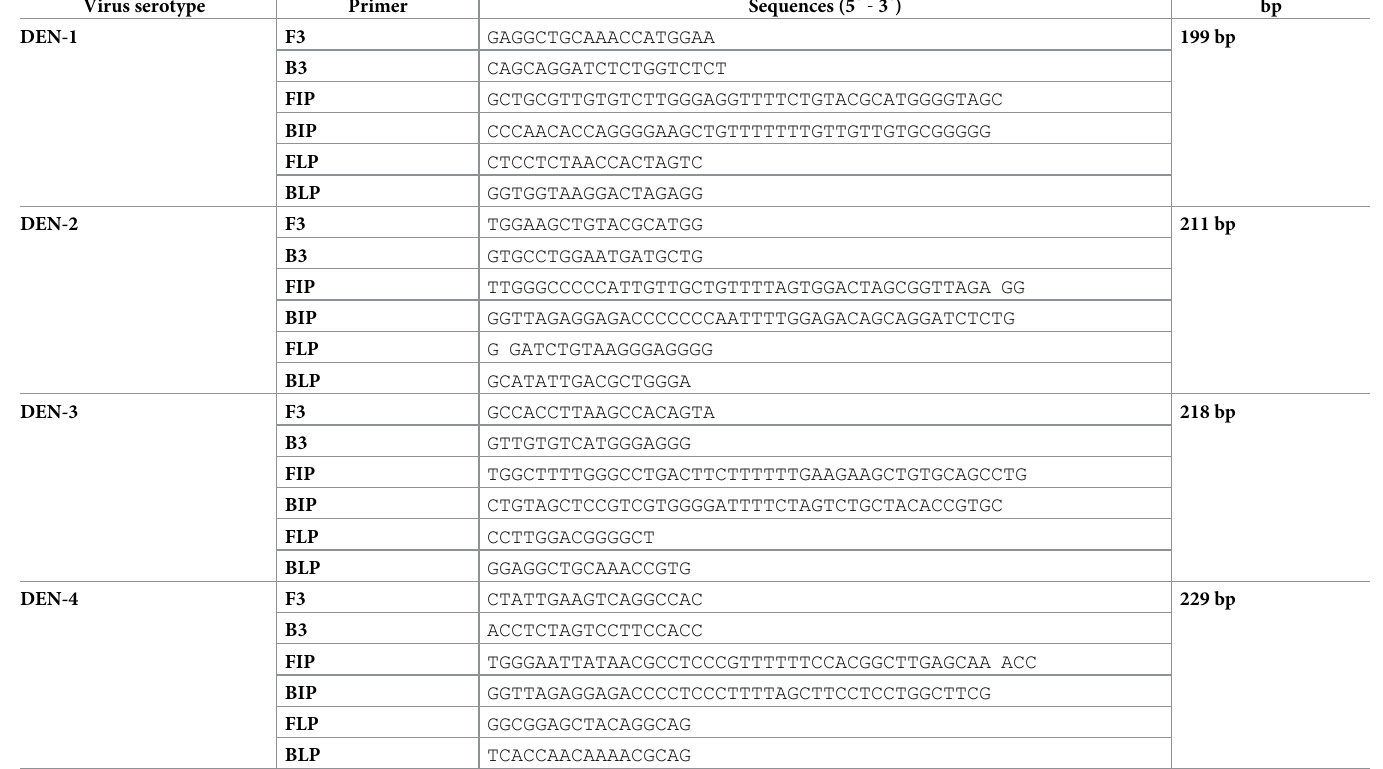
Table 2. Primer sequences used for RT-LAMP targeting DENV serotypes. Virus